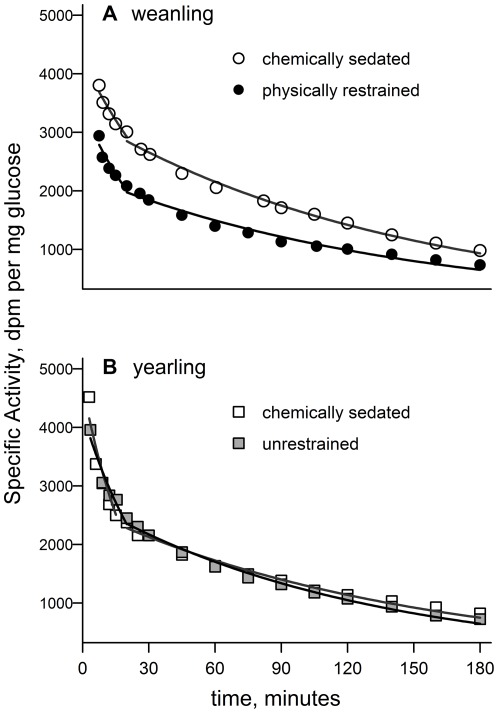
Example of [6-3H]glucose clearance curves used to calculate endogenous glucose production (EGP).Curves are shown for one weanling and one yearling with and without the use of anesthetic agents using the same tracer dose. The lower specific activity observed in the weanling under physical restraint compared to chemical sedation indicates increased dilution of the label from higher rates of EGP under physical restraint. Equivalent 3H doses were administered to each seal, 100 µCi. dpm—disintegrations per minute.